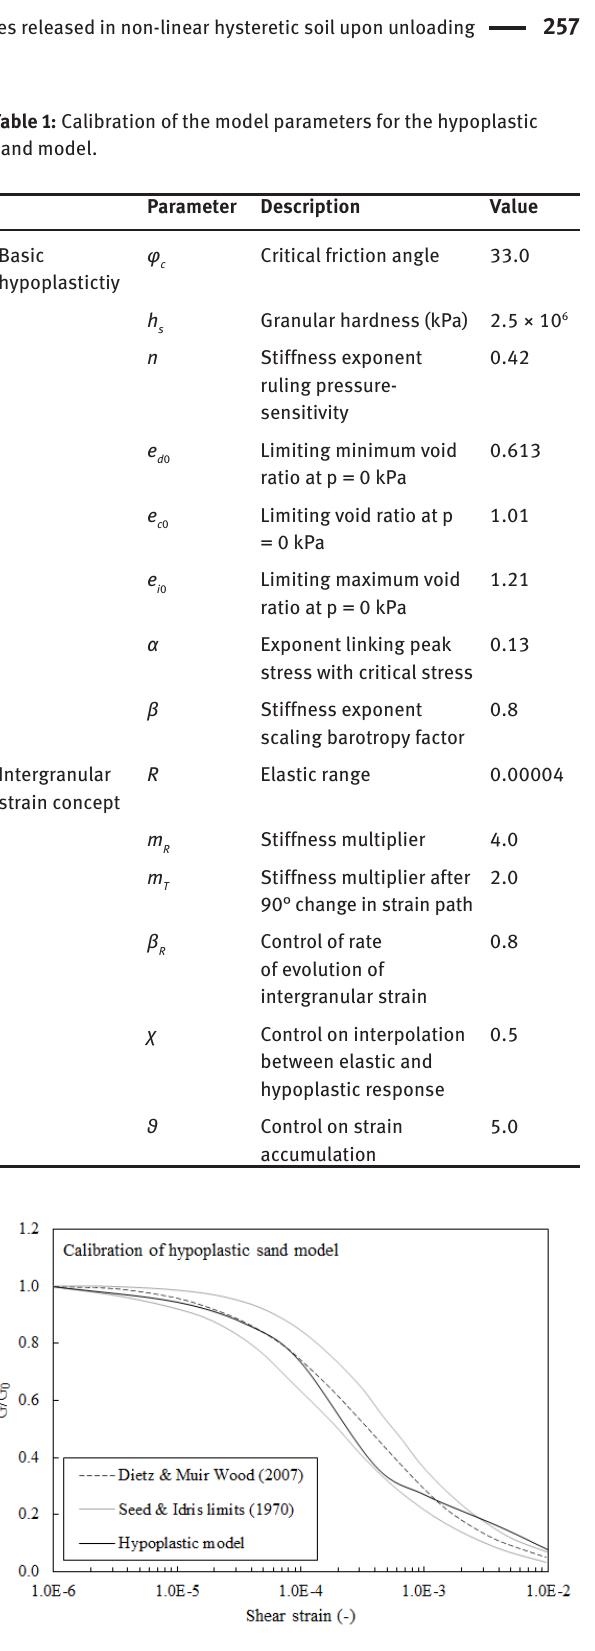
Figure 3: Calibration of the hypoplastic sand constitutive model in terms of shear stiffness degradation G/G